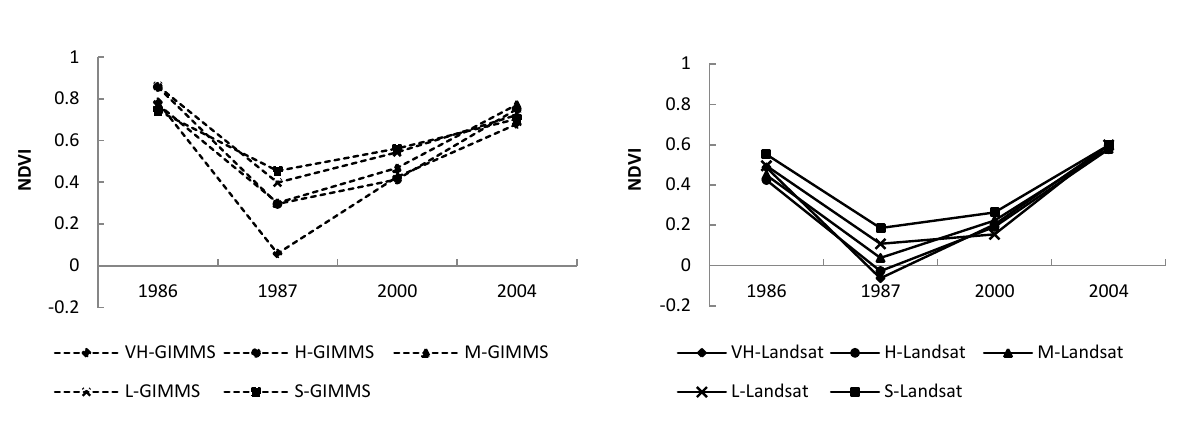
Figure 11. Comparison GIMMS NDVI ( left ) with Landsat NDVI ( right